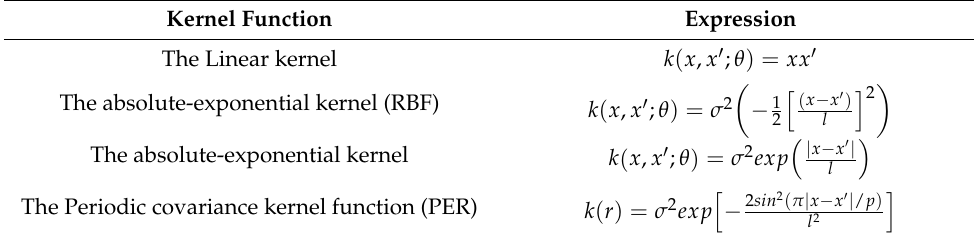
Table 4. The commonly used kernel